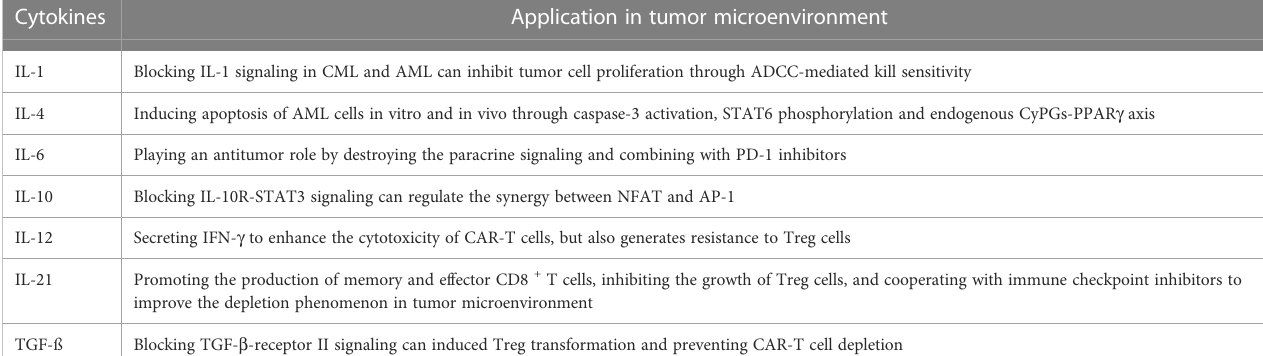
TABLE 1 The role of cytokines in tumor microenvironment.